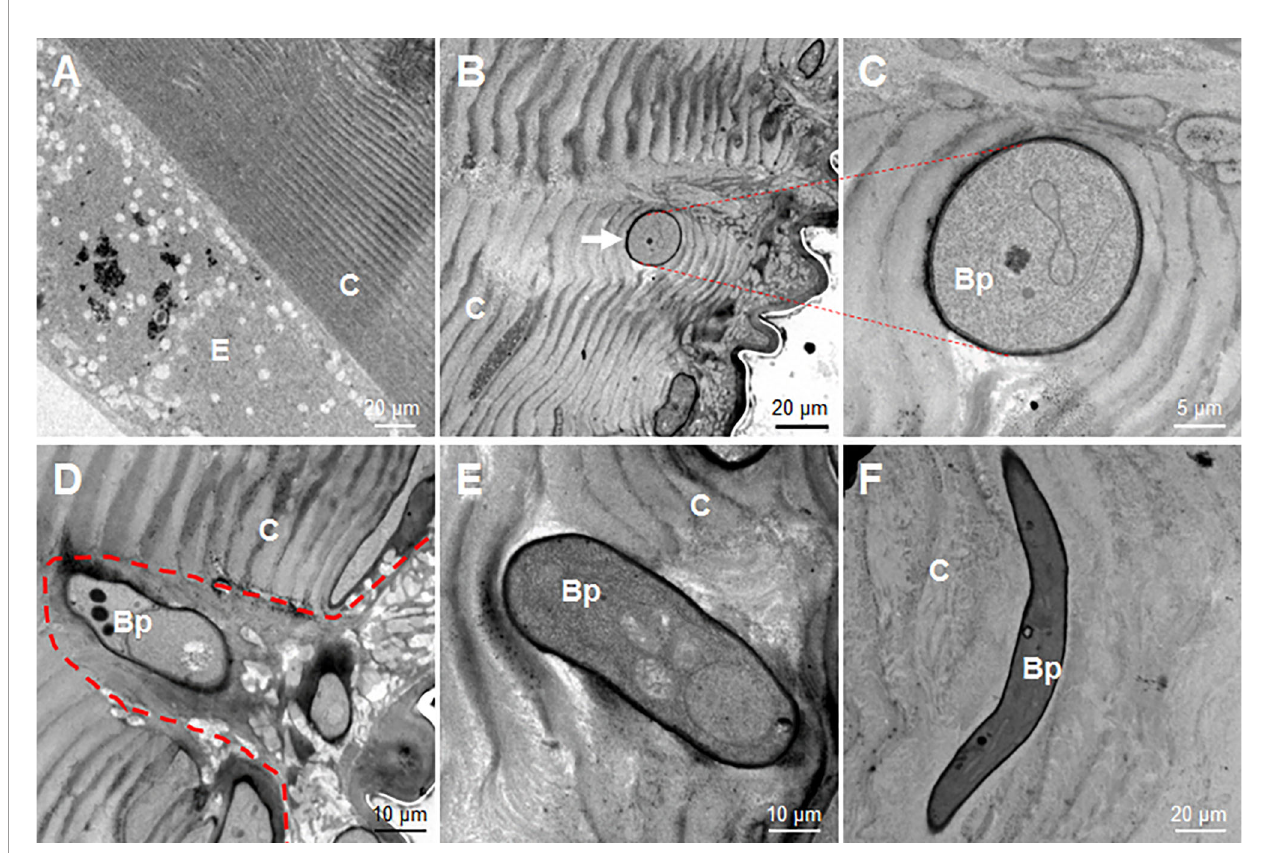
FIGURE 4 | Morphology of B. bassiana hyphae using transmission electron microscopy. After the fi xed-site infection, the infected integuments and the naive ones were sampled at 36 h for observation via transmission electron microscopy. (A) Morphology of cuticle and epidermis cells from a naive larva. The structure of the cuticle was regular in the naive cuticle. (B – F) Hyphae in the cuticle of larvae that received the fi xed-site infection. (B, C) A hyphae penetrated its way along two pieces of cuticle lamina and was sectioned vertically. The enlarged intersecting surface of this hypha and its surrounding cuticle lamina are shown in (C) . (D) A newly- developed hypha degraded the cuticle to form an empty cavity at the beginning of infection. (E, F) Two hyphae inside the cuticle far from the epicuticle. They penetrated in different directions without further degradation of the surrounding cuticle. In each image, the small letter “ E ” and “ C ” represent epidermis cells and cuticle